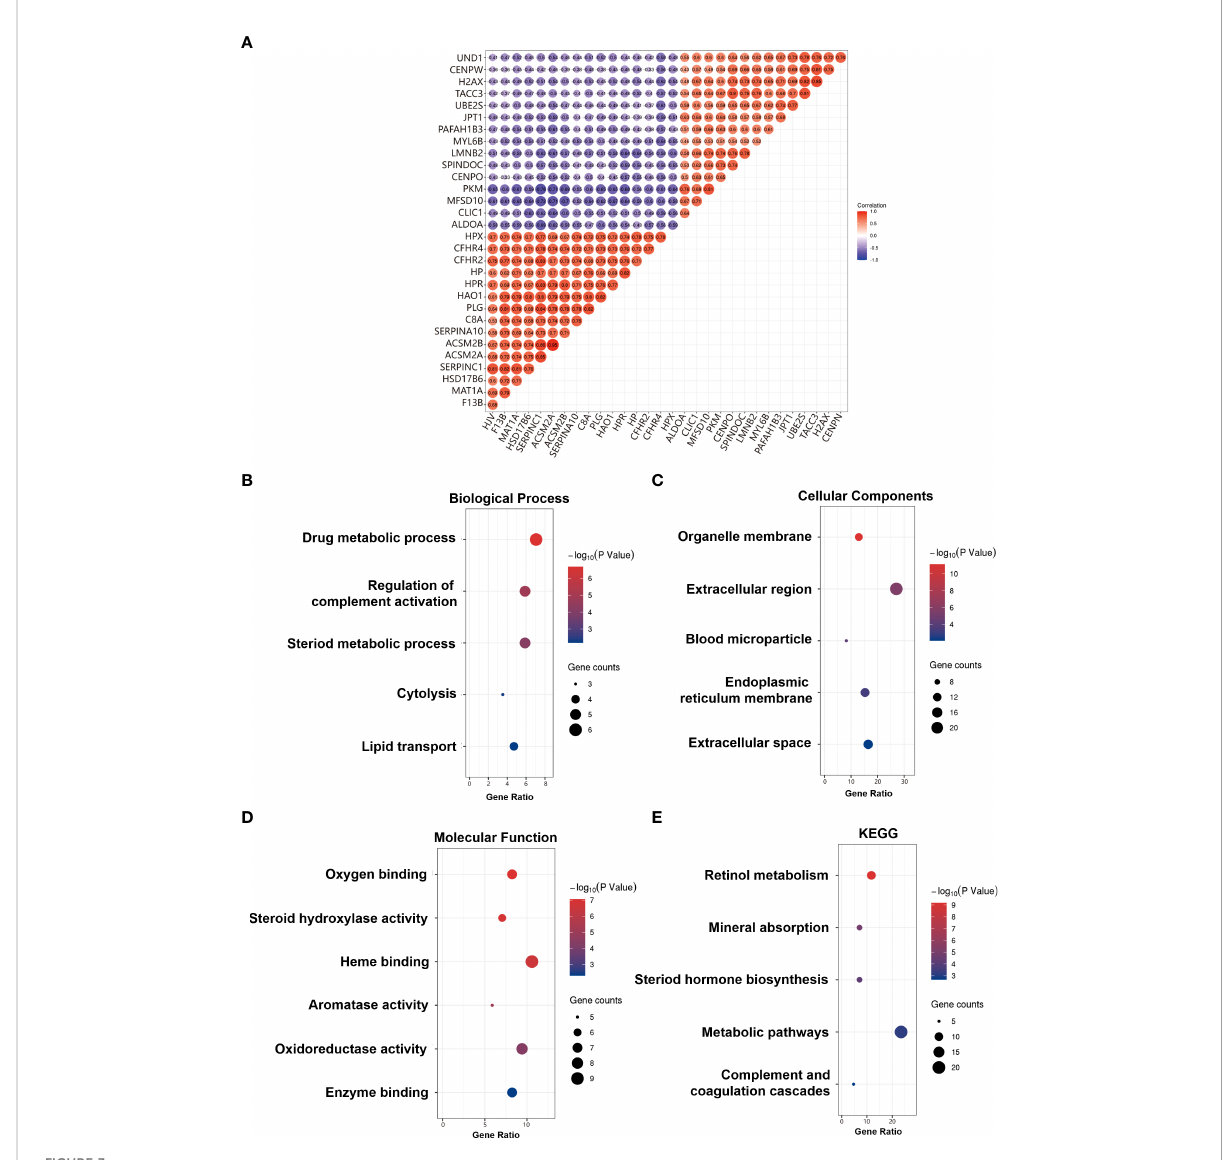
FIGURE 3 Correlation and GO/KEGG enrichment analysis results. (A) Heat map of positive and negative correlation genes with CFHR4 (Top 10). (B) GO_BP enrichment results. (C) GO_CC enrichment results. (D) GO_MF enrichment results. (E) KEGG enrichment